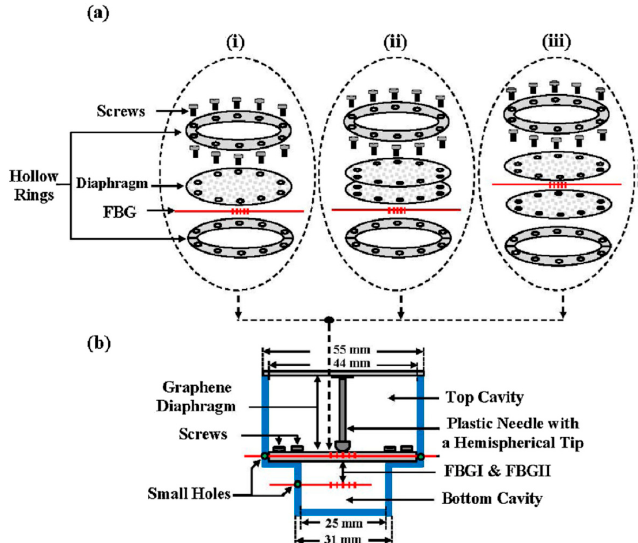
Figure 5. Experimental architecture: ( a ) diaphragm incorporated FBG positioned between two hollow rings, (i) a single sheet of graphene diaphragm on the top of FBG, (ii) two sheets of graphene on the top of FBG, (iii) two sheets of graphene between FBG called sandwich layer. ( b ) Sandwich layers of the sensor head structure [168]. Copyright © 2016, Elsevier B.V.